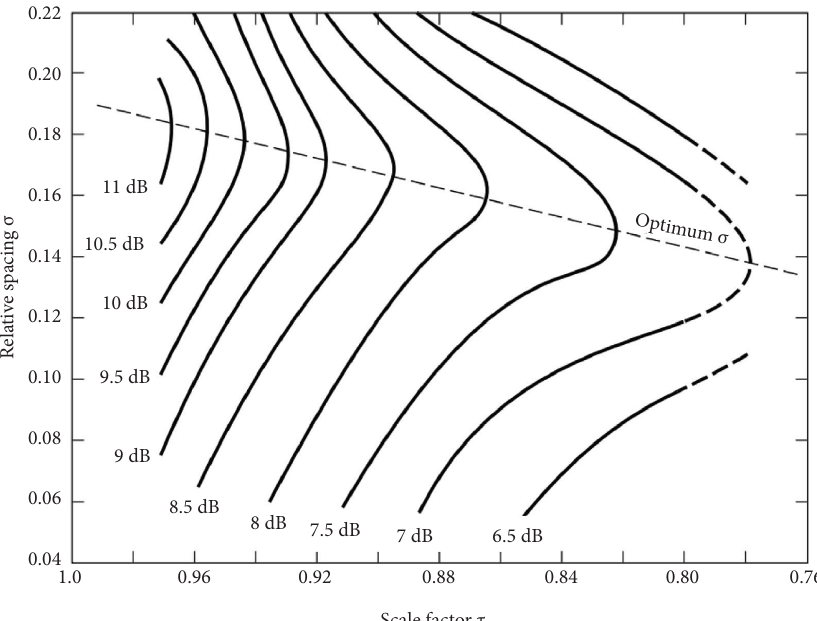
Figure 2: Computed contours of constant directivity versus σ and τ for log-periodic dipole arrays.